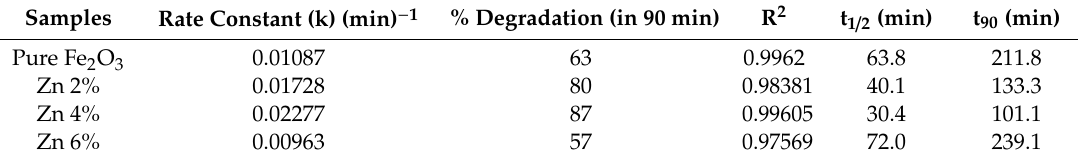
Figure 9. Bar diagram of ( a ) % degradation and ( b ) electricity cost in Indian rupees for degradation of RB dye with pure Fe 2 O 3 , Zn 2%, Zn 4% and Zn 6% nanoparticles. 3.5.2. Electricity Cost Cost evaluation is one of the most important factors in waste water treatment. As saving energy (electricity) benefits the world at large scale. The main reason behind saving electricity is that burning of fossil fuels in plants causes several environmental issues, such as global warming and the greenhouse effect, which directly affect human life. Our present study aims to reduce energy to